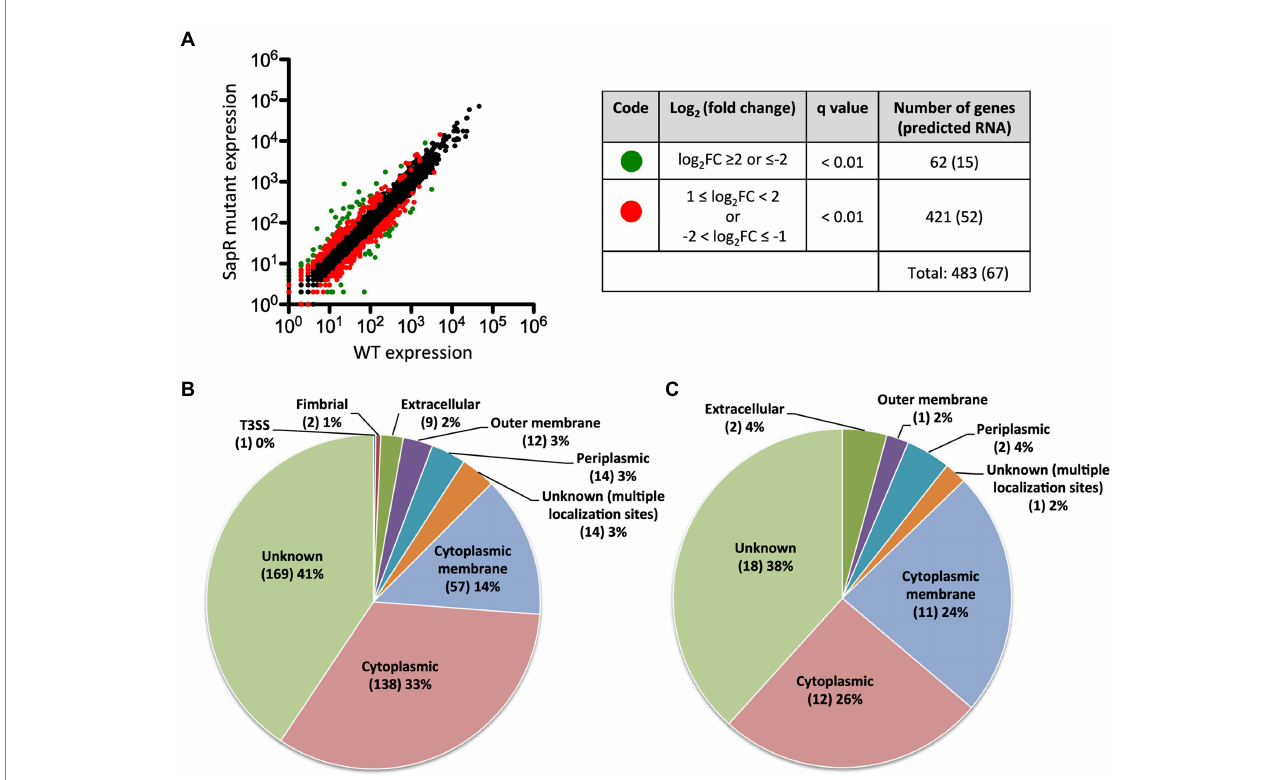
FIGURE 5 SapR differentially regulates genes in many subcellular locations. (A) Expression values generated from Rockhopper of all detected genes were used to create the plot. A total of 483 DEGs are highlighted. Sixty-two genes with a q -value < 0.01 and a log 2 FC ≤ − 2 or ≥ 2 are highlighted in green, and 421 genes with 1 ≤ log 2 FC < 2 or − 2 < log 2 FC ≤ − 1 are highlighted in red. Numbers of predicted RNAs shown in parentheses were not included in this analysis. (B) The 416 DEGs with a cut off of a log 2 FC ≤ − 1 or ≥ 1 were further analyzed based on their assigned subcellular localization from Burkholderia.com. (C) A large enrichment was showed in proteins associated with cytoplasmic membrane while increasing the stringency to cut off of a log 2 FC ≤ − 2 or ≥ 2. Number of genes in each category was presented in parenthesis followed by its